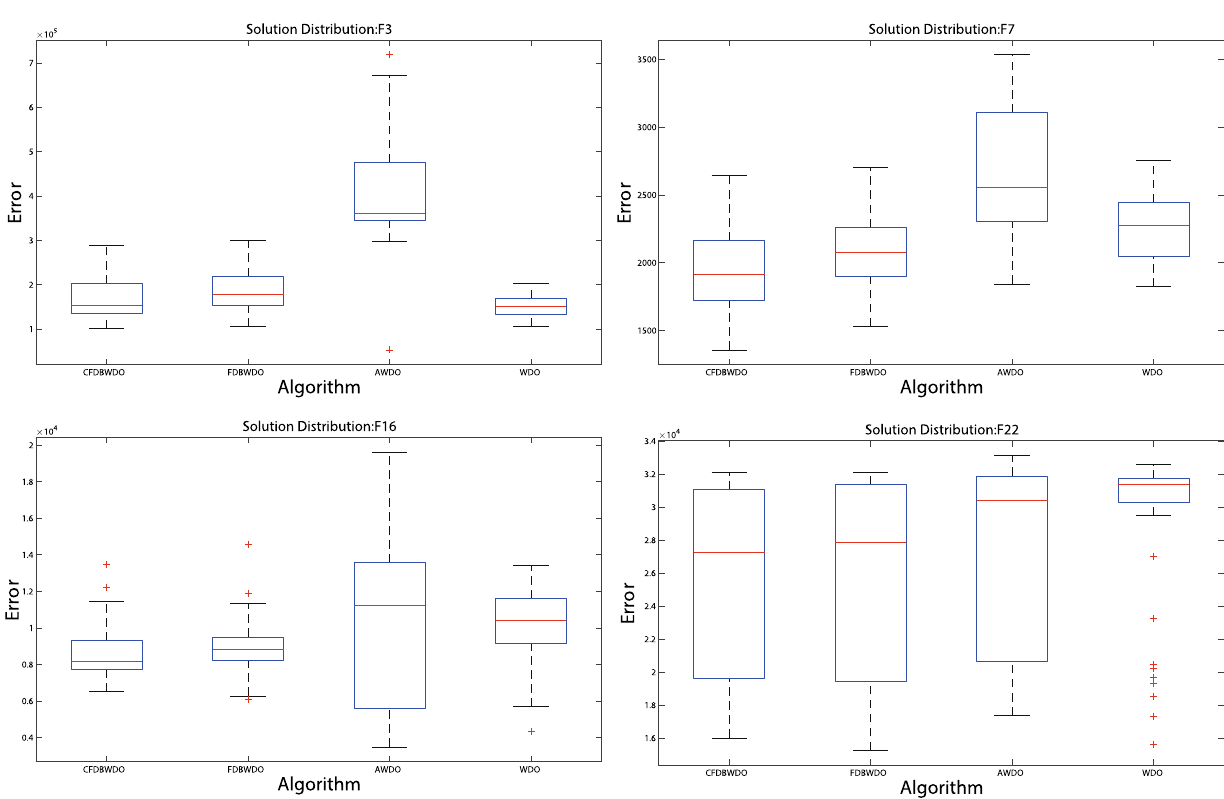
Fig. 9 Box-and-whisker diagrams of four WDO variants on F3, F7, F16 and F22 with 100